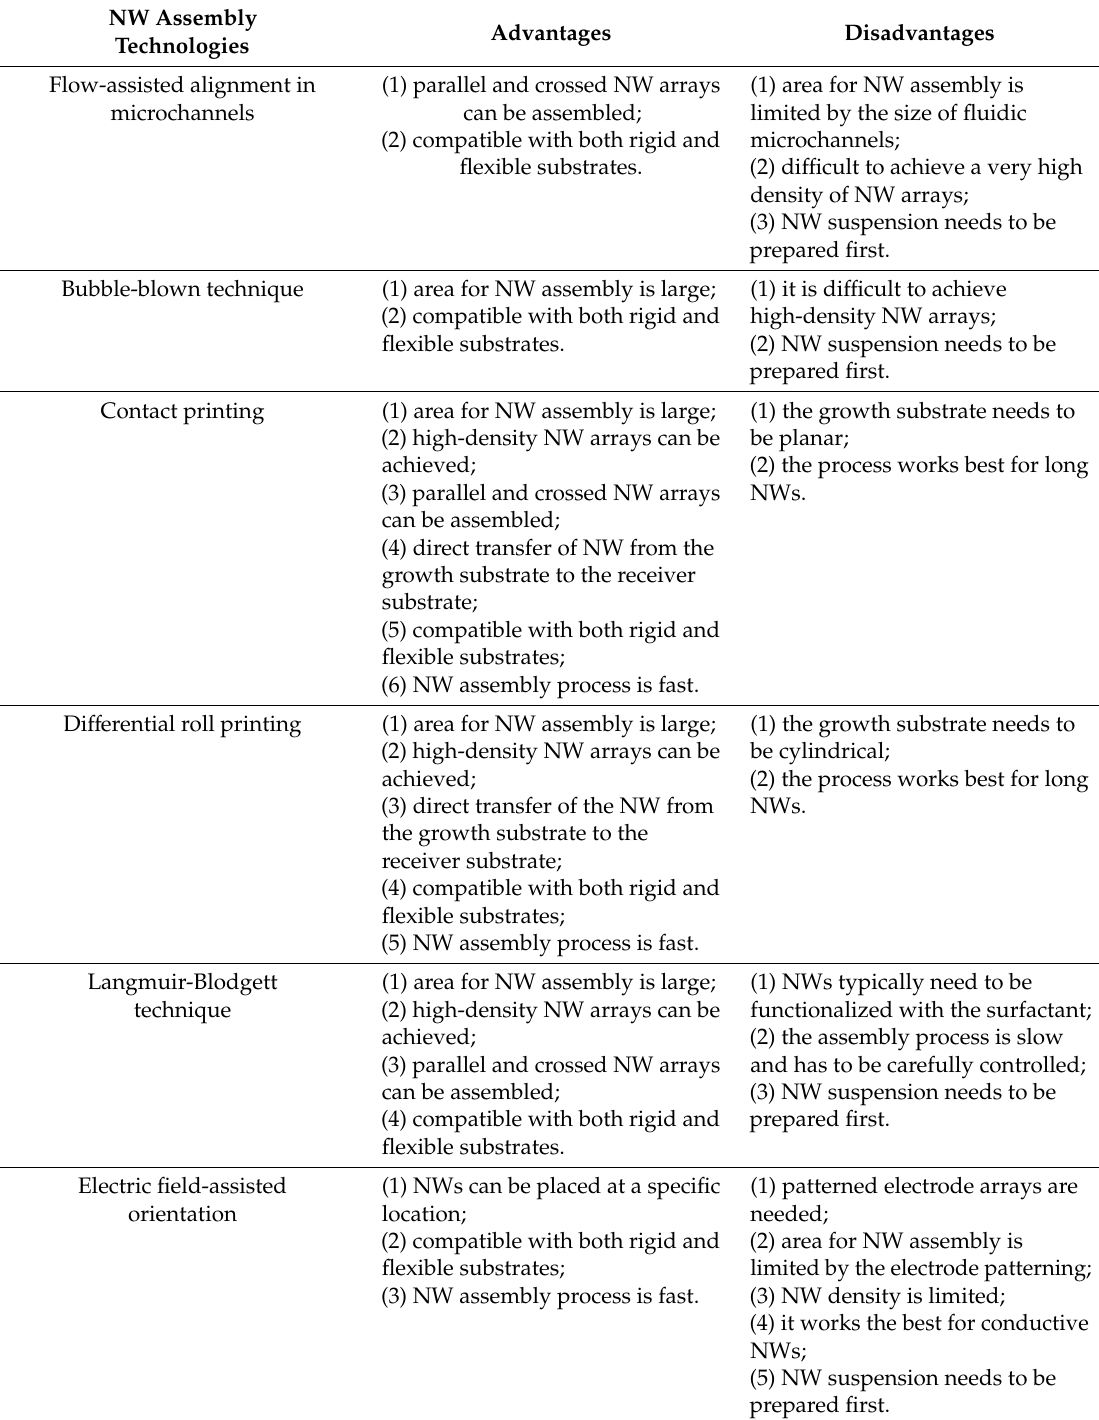
Table 3. Summary of the NW assembly